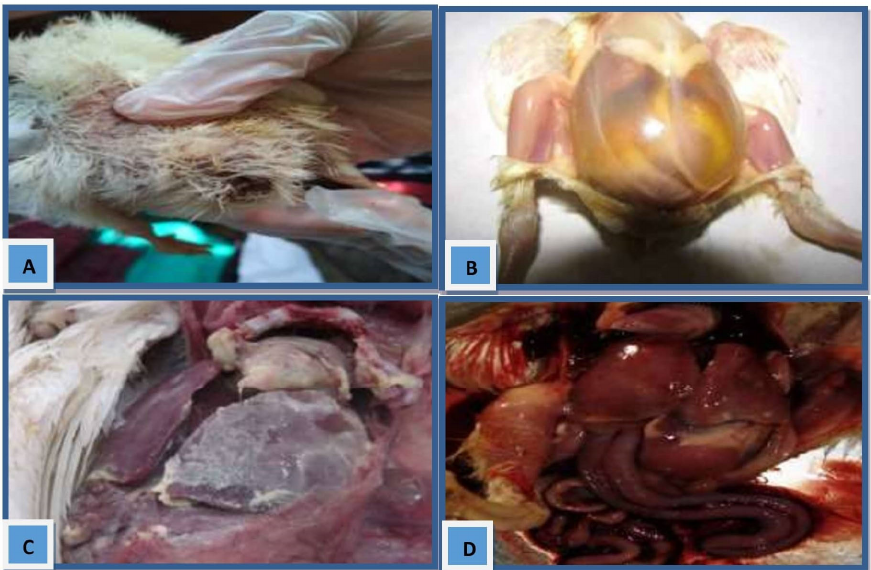
Fig. 4. Gross lesions found in chickens in case of colibacillosis. A: Omphalitis B: Fibrinopurolent fluid accumution in peritoneal cavity C: Airsacculitis, pericarditis and perihepatitis D: Extreme congestion and septicemia in